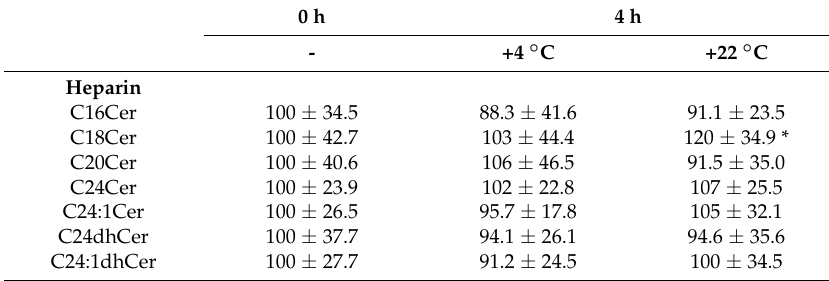
Table 2. Time-dependent effect on relative sphingolipid levels in human blood samples.